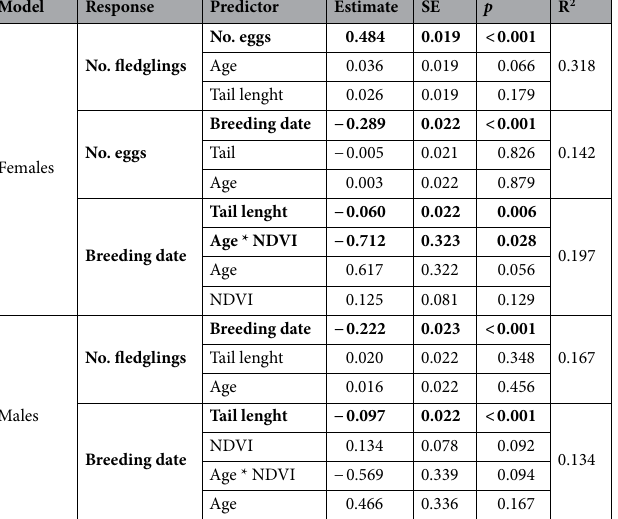
Table 2 has also been corrected. The original version of this Table is reproduced below for reference: